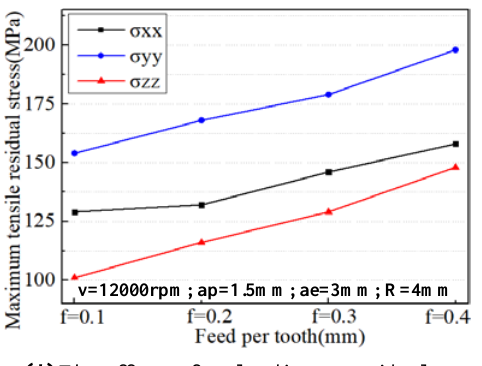
(d) The effects of tool radius on residual stress Fig. 4. The effects of milling parameters on residual